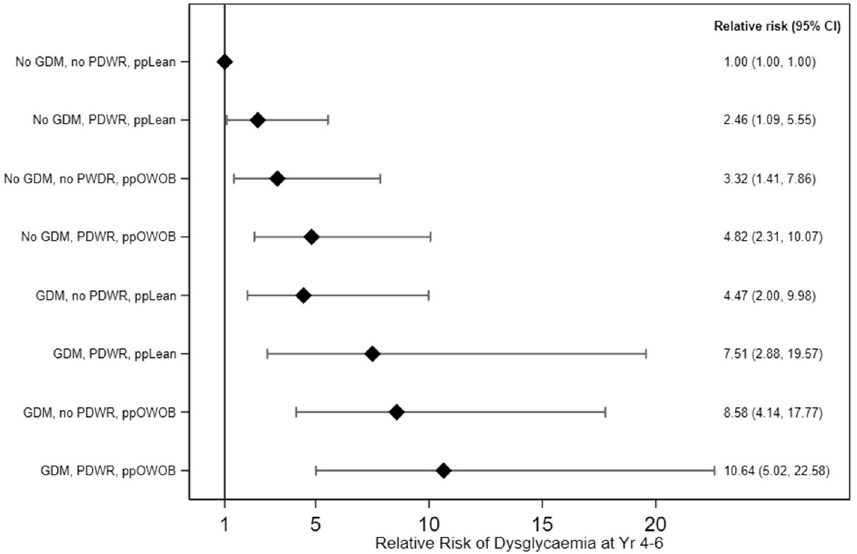
Figure 1. Relative risk of dysglycaemia at 4–6 years post-delivery according to combinations of peri- pregnancy risk factors. The diamonds and capped lines represent point estimates and 95% confidence intervals, respectively, of relative risk of having dysglycaemia at 4–6 years post-delivery according to combinations of peri-pregnancy risk factors. Reference group comprised participants without any of the risk factor. Estimates are adjusted for ethnicity, age at delivery, education, parity, family history of diabetes, insulin treatment during pregnancy and pregnancy induced hypertension. GDM gestational diabetes mellitus, PDWR post-delivery weight retention (≥ 5 kg) at 4 years, ppLean pre-pregnancy lean (BMI < 23 kg/m 2 ), ppOWOB pre-pregnancy overweight or obese (BMI ≥ 23 kg/m 2